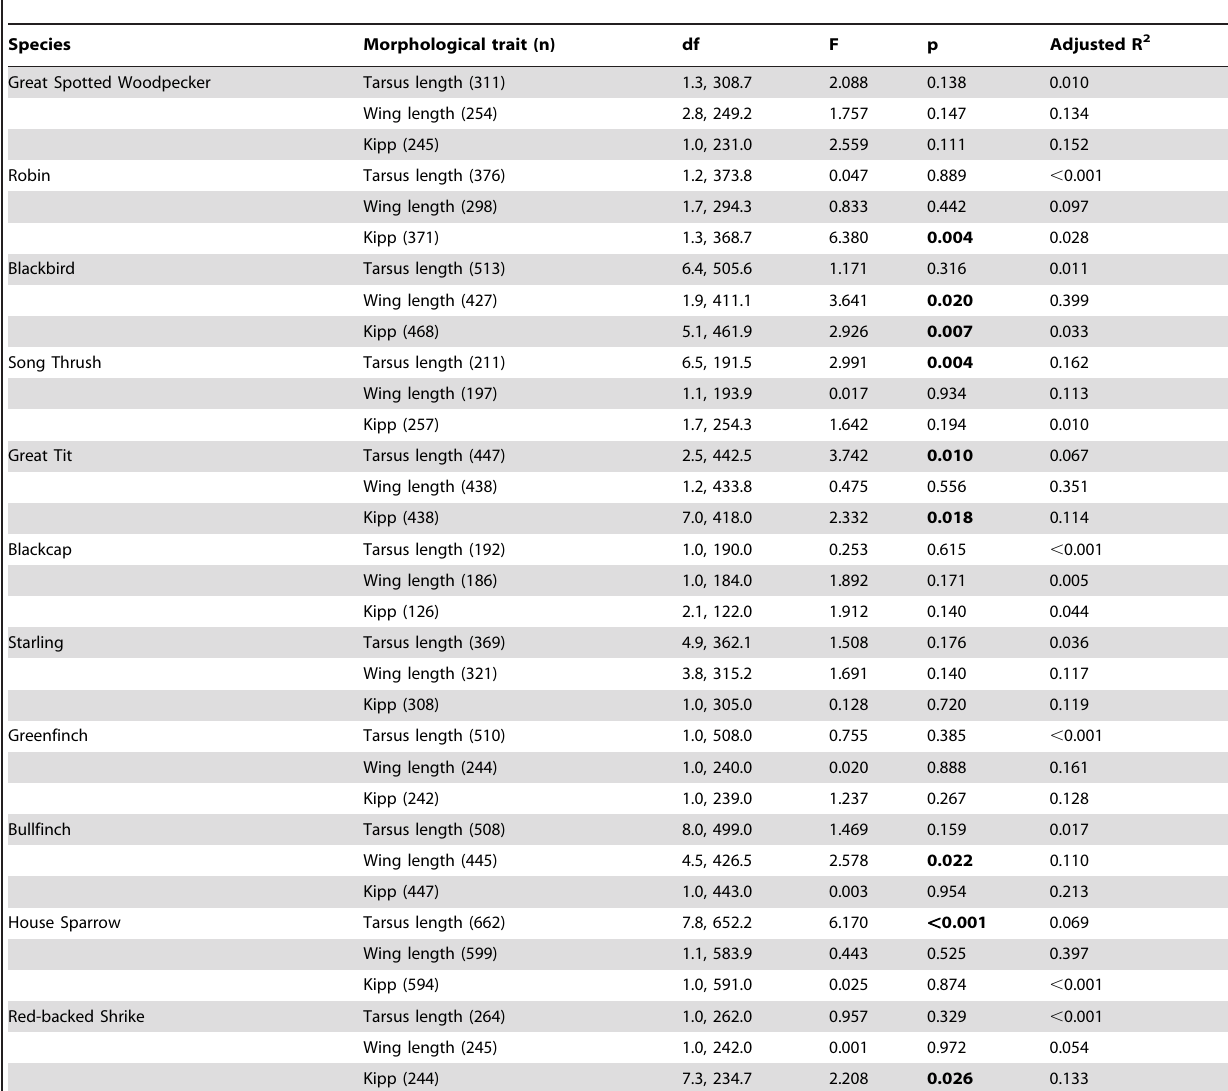
Table 3. Association of three morphological variables for 11 bird species with the smooth term ‘‘temperature’’ in a GAM.